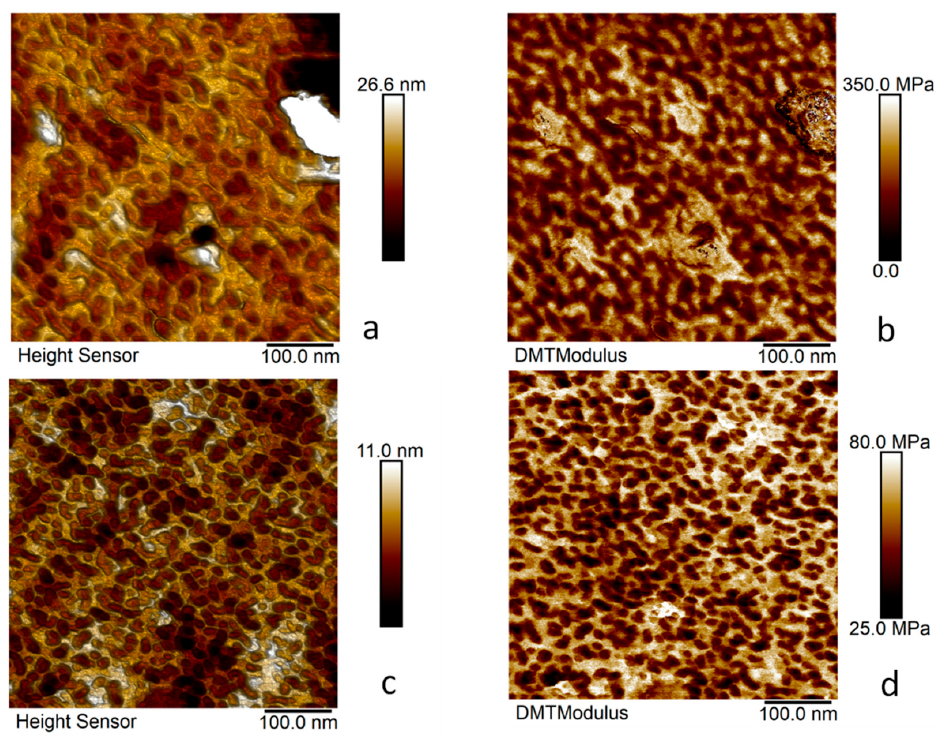
Figure 4. AFM stiffness mapping of the membranes for ( a , b ) SEBS-Py2O6 and ( c , d )